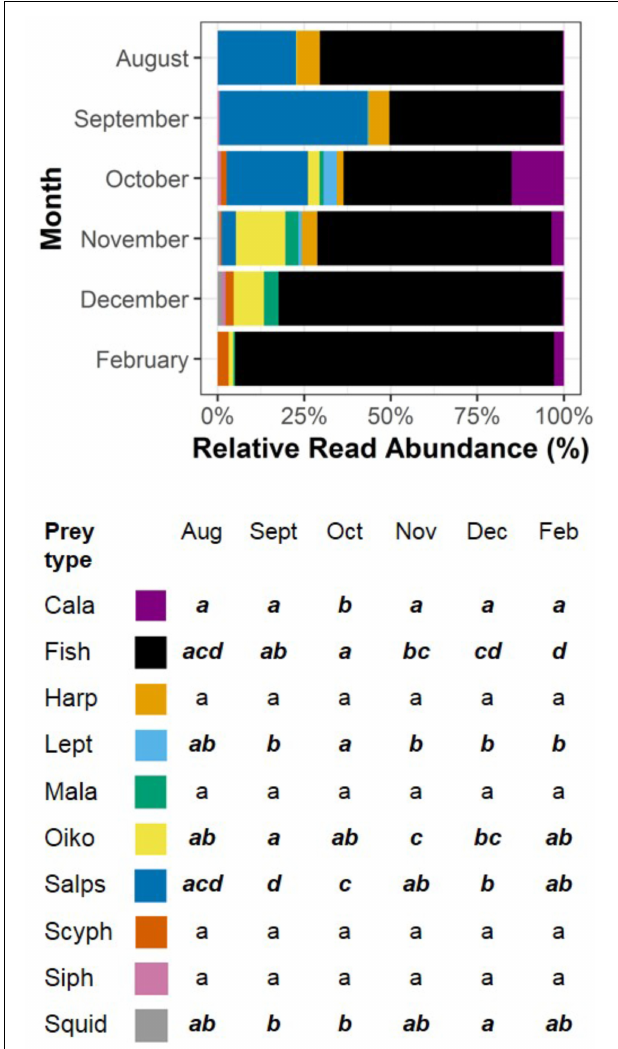
FIGURE 3 | The RRA (%) of the 10 most common taxa in fecal samples over surveyed months of the breeding season. The percentages for each taxon over months are accompanied by a compact letter display indicating significant differences between months. Months with the same letter are considered similar to each other, and months with different letters are considered significantly different from one another. Significant differences are also denoted by bold, italic text. Note that January was not included in analyses due to insufficient sample size. Taxa are Cala = Calanoids,